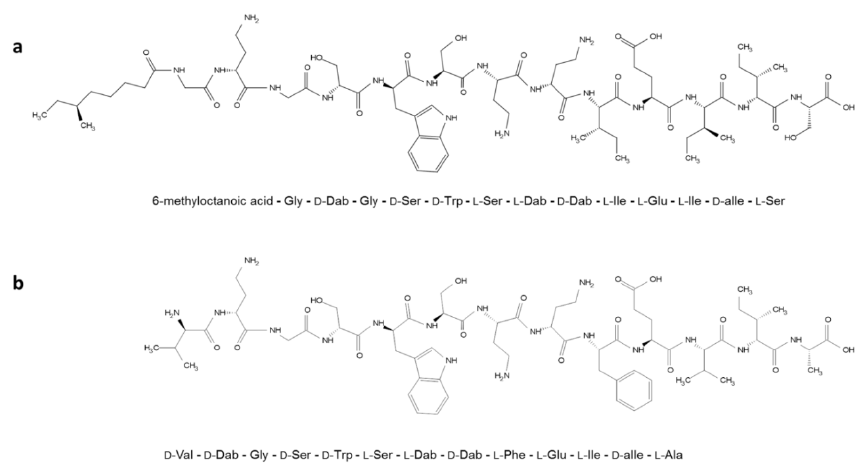
Figure 1. Chemical structures and amino acid sequences of ( a ) tridecaptin M and ( b ) unacylated tridecaptin A 1 . The lipid moiety in natural tridecaptin A 1 is 6-methyl-3-hydroxy octanoic acid.